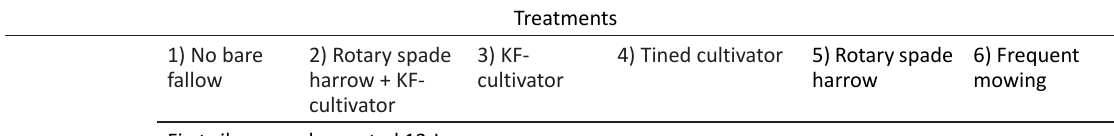
Table 3. Treatments and other farming operations in experiment 2 in 2013–2014